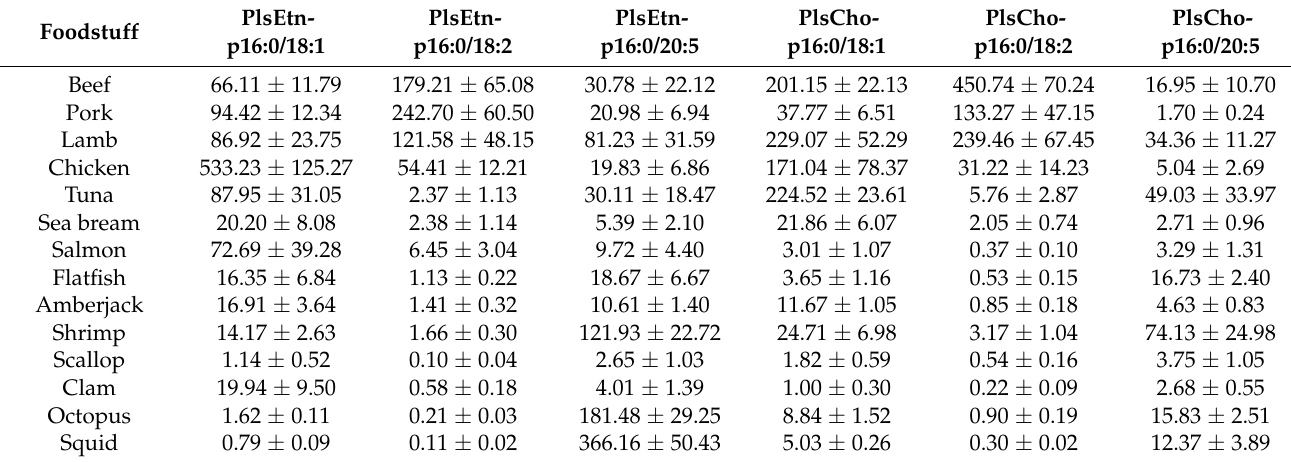
Table 3. Amount of each plasmalogen species in foodstuffs (nmol/g, means ± SD).